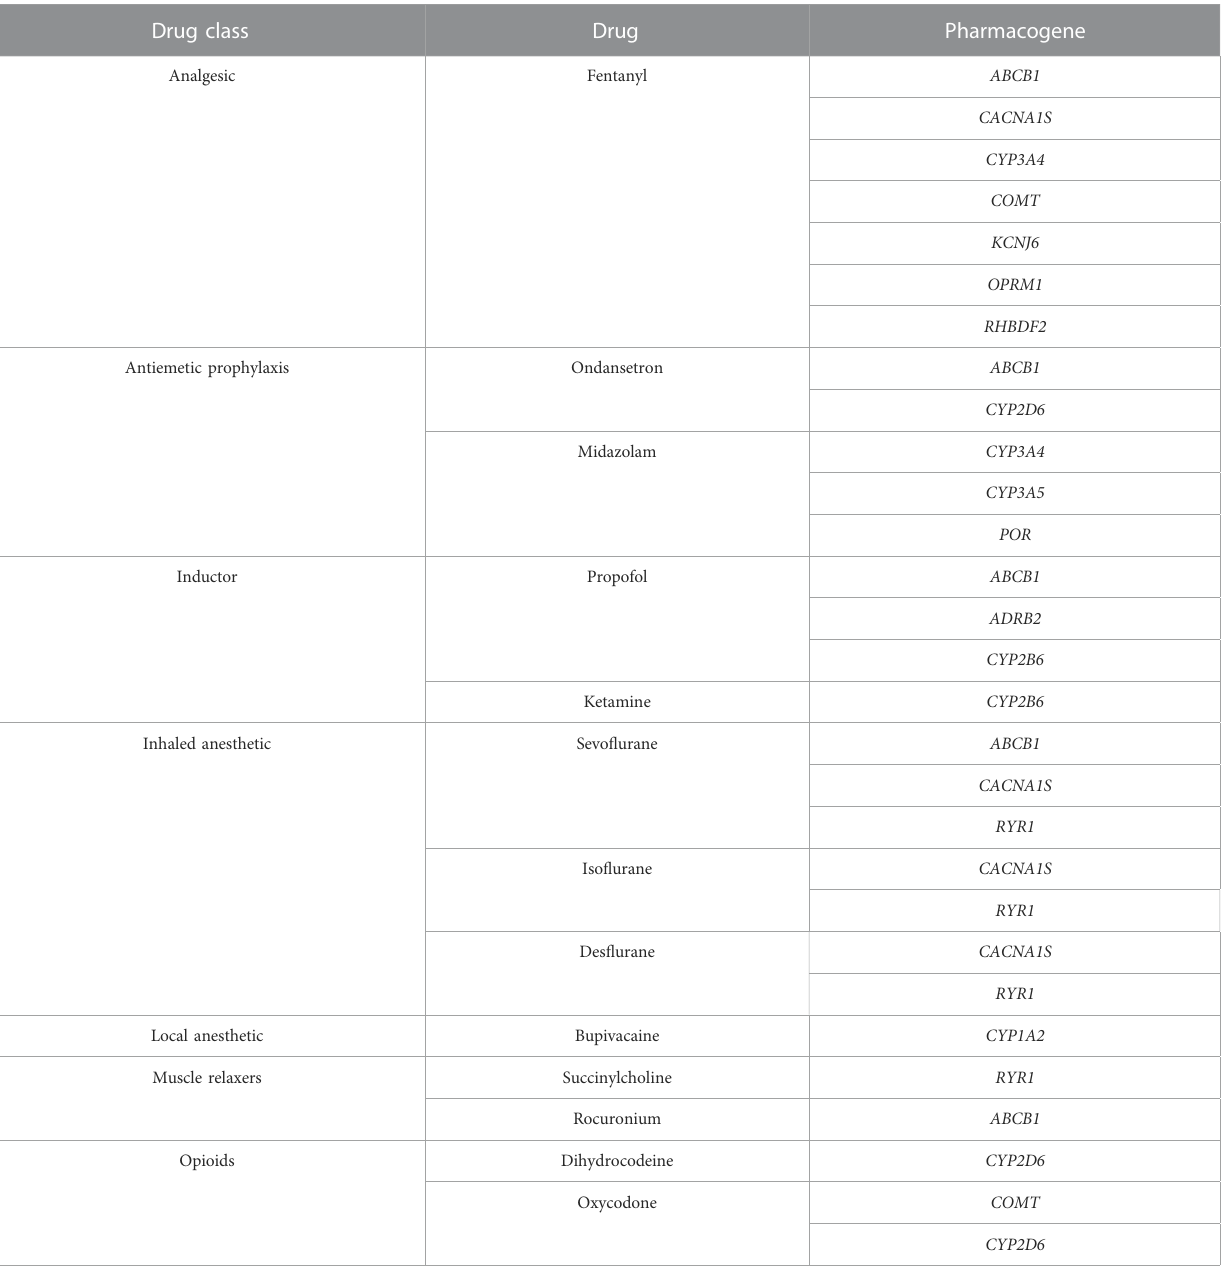
TABLE 1 Anesthesia gene panel for WES